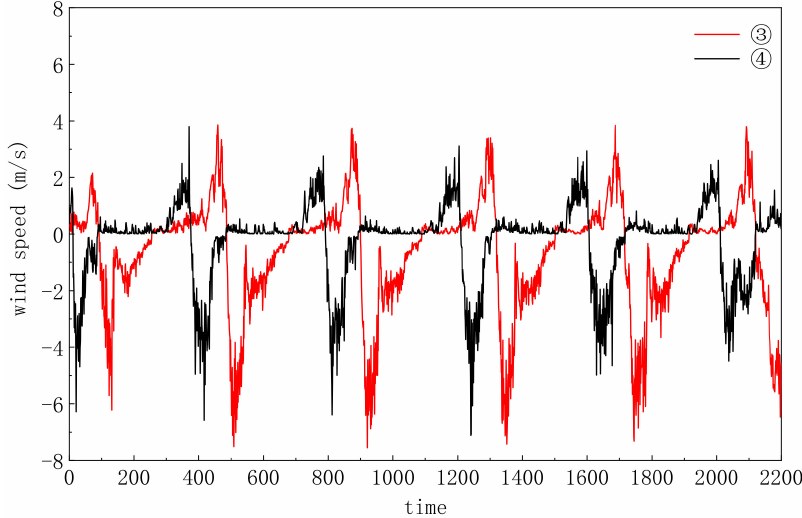
Figure 8. Wind speed variations at the inner openings of middle air shafts 3 (cid:13) and 4 (cid:13)